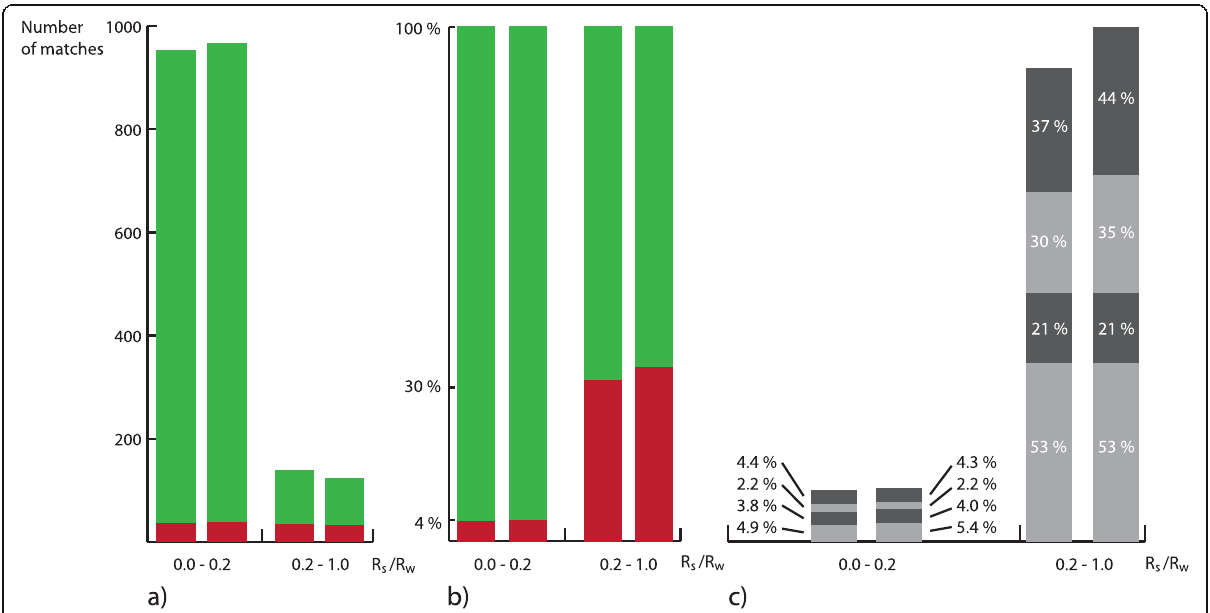
Fig. 16 a Numbers of correct (green) and incorrect (red) matches. b Percentages of correct (green) and incorrect (red) matches. c Error rates of incorrect matches for (from bottom to top) text/text, text/original image examples, text/second set of image examples, and original image examples/second set of image examples. For the pairs of bars, the left bar always represents the R S value and the right bar the R W